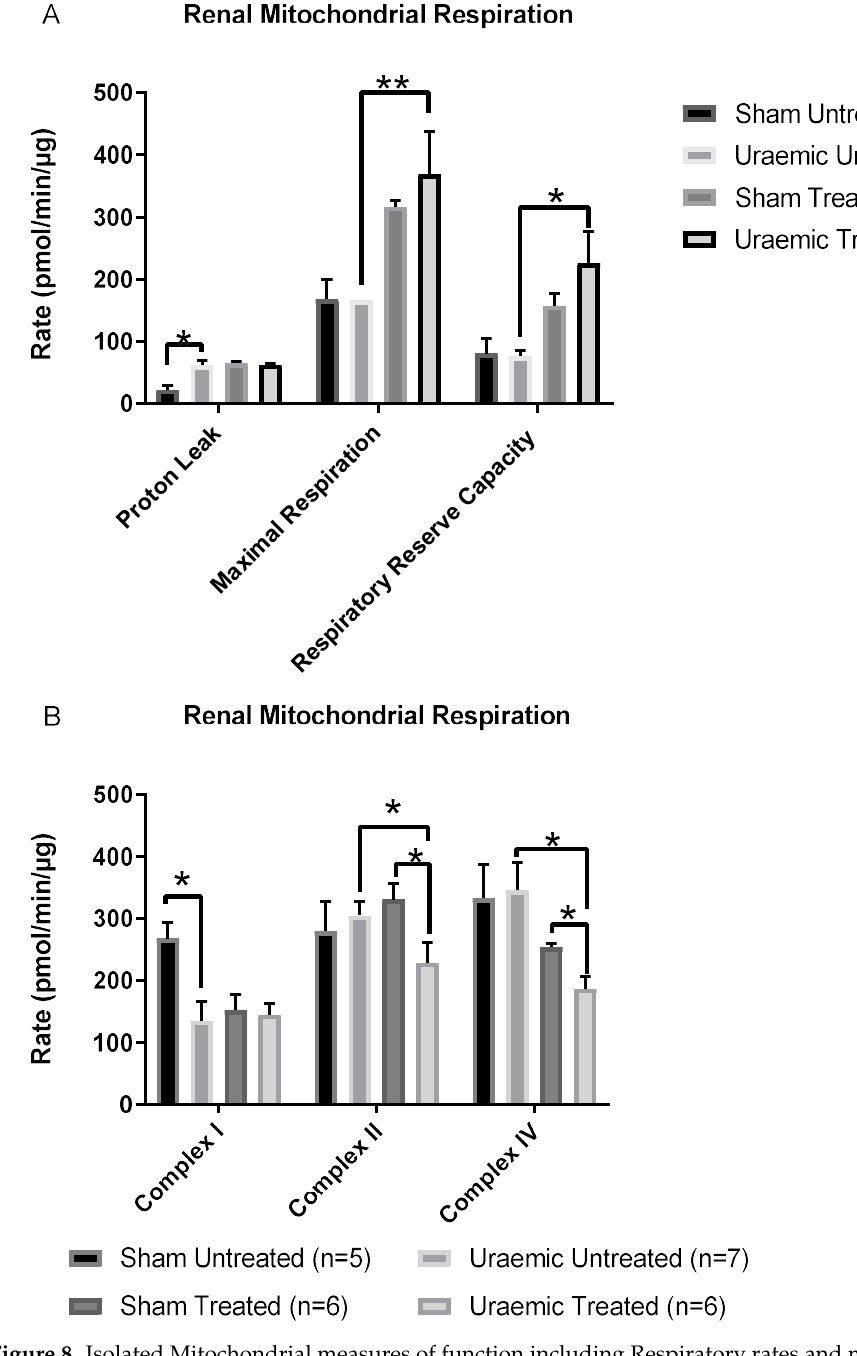
Figure 8. Isolated Mitochondrial measures of function including Respiratory rates and mitochondrial respiration in the presence of: ( A ) 0.5 µ g mitochondrial protein, 10 mM succinate and 2 µ M rotenone; ( B ) 0.6g mitochondrial protein, 10 mM pyruvate, 2 mM malate and 4 µ M FCCP (carbonyl cyanide 4-(trifluoromethoxy) phenylhydrazone) with or without 10 mM malonate. In Fig 8B the electron transport chains complexes I, II and IV were measured. Results are presented as mean ± SEM. (* p < 0.05; ** p < 0.01). Proton leak = (minimum rate measured after Oligomycin injection) − (non-mitochondrial respiration rate or minimum rate measured after injection of Antimycin A); Maximal respiration = (maximal rate measured after FCCP injection) – (non-mitochondrial respiration rate); Respiratory reserve capacity = (maximal respiration – basal